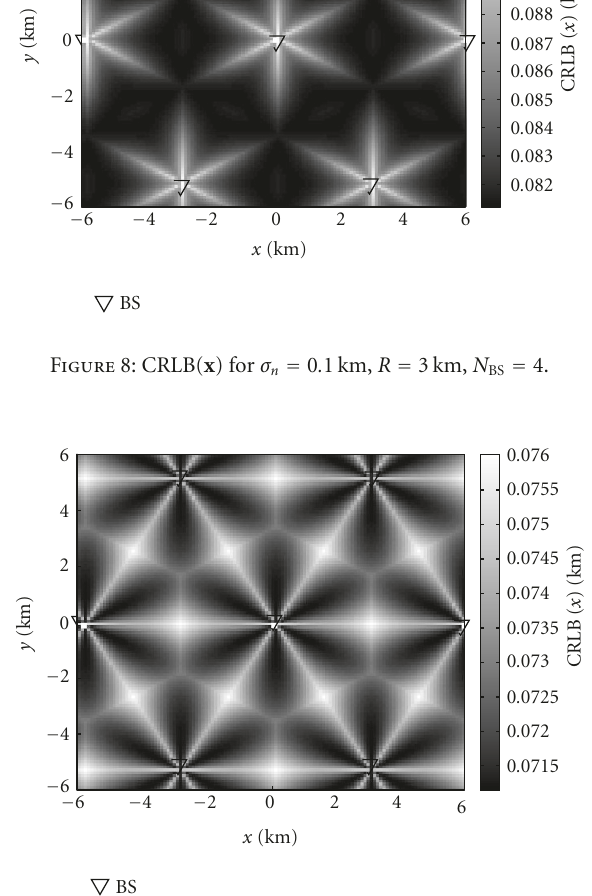
Figure 9: CRLB( x ) for σ n = 0 . 1km, R = 3km, N BS = 5.